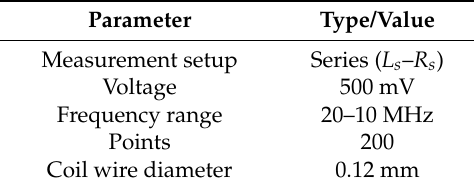
Table 2. Experiment setup parameters.